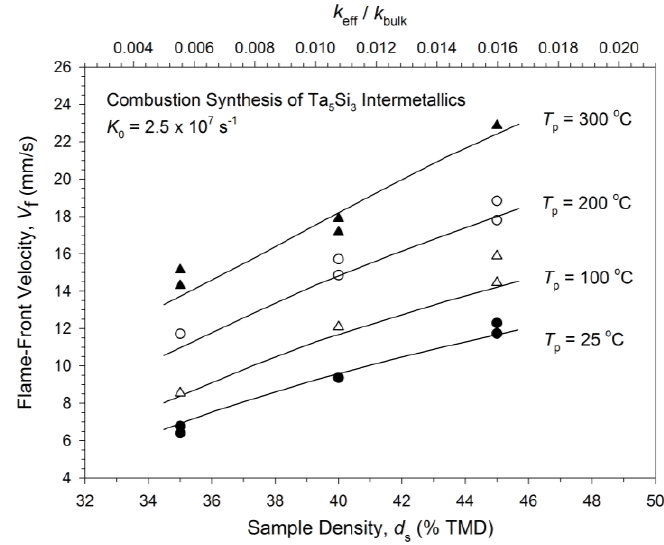
Figure 7. A comparison between measured and calculated flame-front velocities as functions of sample density and k eff / k bulk for combustion synthesis of Ta 5 Si 3